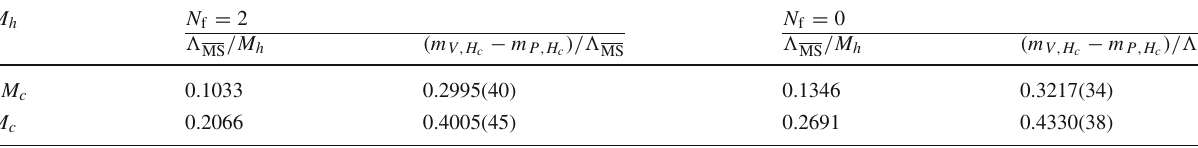
− m )/(cid:6) as a function of (cid:6)/ M h , where M h is the RGI mass of the heavy quark P , H c MS c